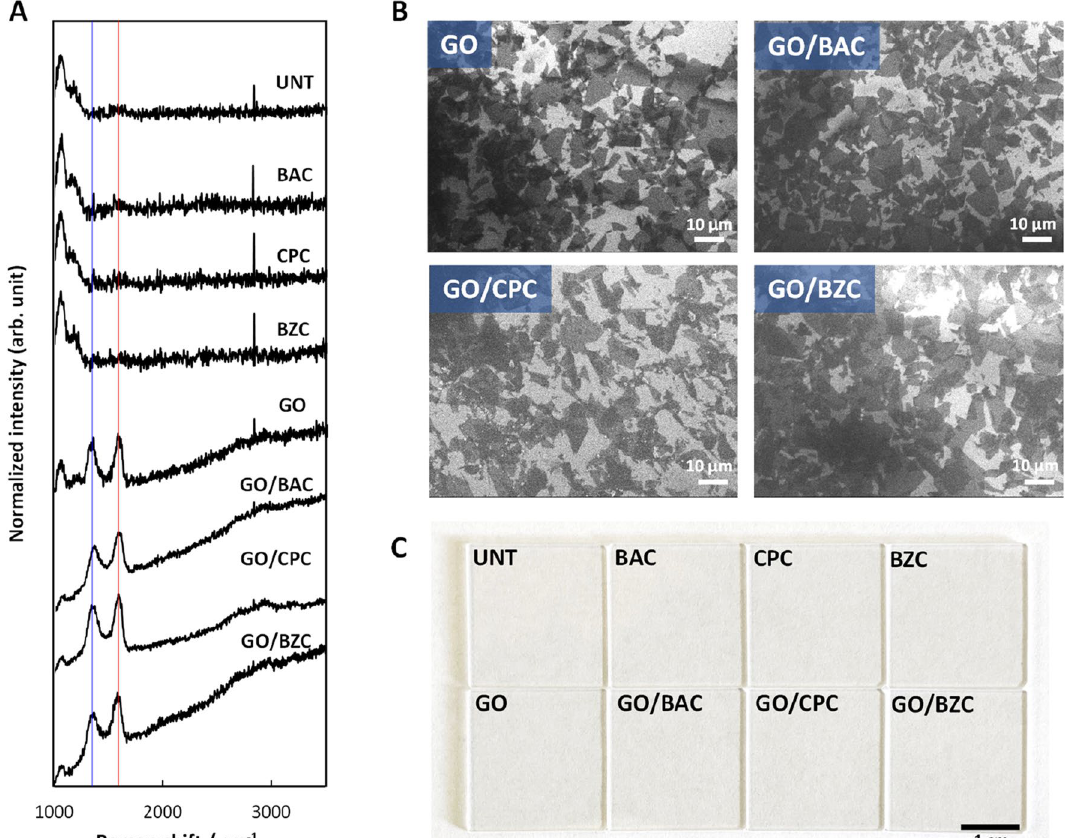
Figure 1. Characterization of GO/CSAA on quartz substrate. ( A ) Raman spectroscopy analyses. The red and blue lines indicate 1600 cm -1 and 1350 cm -1 (G and D bands), respectively. ( B ) SEM images of quartz substrates. ( C ) Digital photographs of quartz substrates. BAC benzalkonium chloride, BZC benzethonium chloride, CPC cetylpyridinium chloride, CSAA cationic surface active agent, GO graphene oxide, SEM scanning electron microscopy, UNT